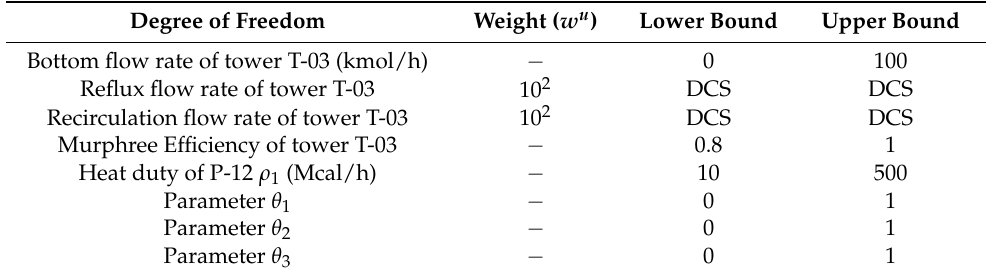
Table 3. Constraints of the Data Reconciliation Problem. Constraint Description Lower Bound Upper Bound Molar fraction of C 4 − in Naphta 0 0.015 Pressure loss on the feed valve of T-03 (kgf/cm 2 ) 1 ∞ Ratio of C 2/ C 5 + in LPG 0 16 Vapor flow rate after flash P108 0 0 Molar flow rate of C 2 in LNG 0 ∞ Heat duty difference of cold and hot side of P-12 0